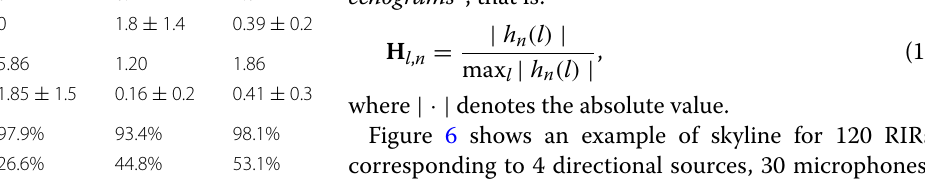
Table 4 Mismatch between geometric measurements and signal measurements in terms of maximum (Max.), average (Avg.), and standard deviation (Std) of absolute mismatch in centimeters Metrics bIPS dMDS dcMDS Geom. Max. 0 6.1 1.07 0.39 ± 0.2 Signal Max. 0.41 ± 0.3 Mismatch GoM (0.5 ms) 97.9% 93.4% 98.1% GoM (0.1 ms) 26.6% 44.8% 53.1% GoM (0.05 ms) 12.5% 30.2% The goodness of match (GoM) between the signal and geometrical measurements is reported as the fraction of matching echo timings for different thresholds in